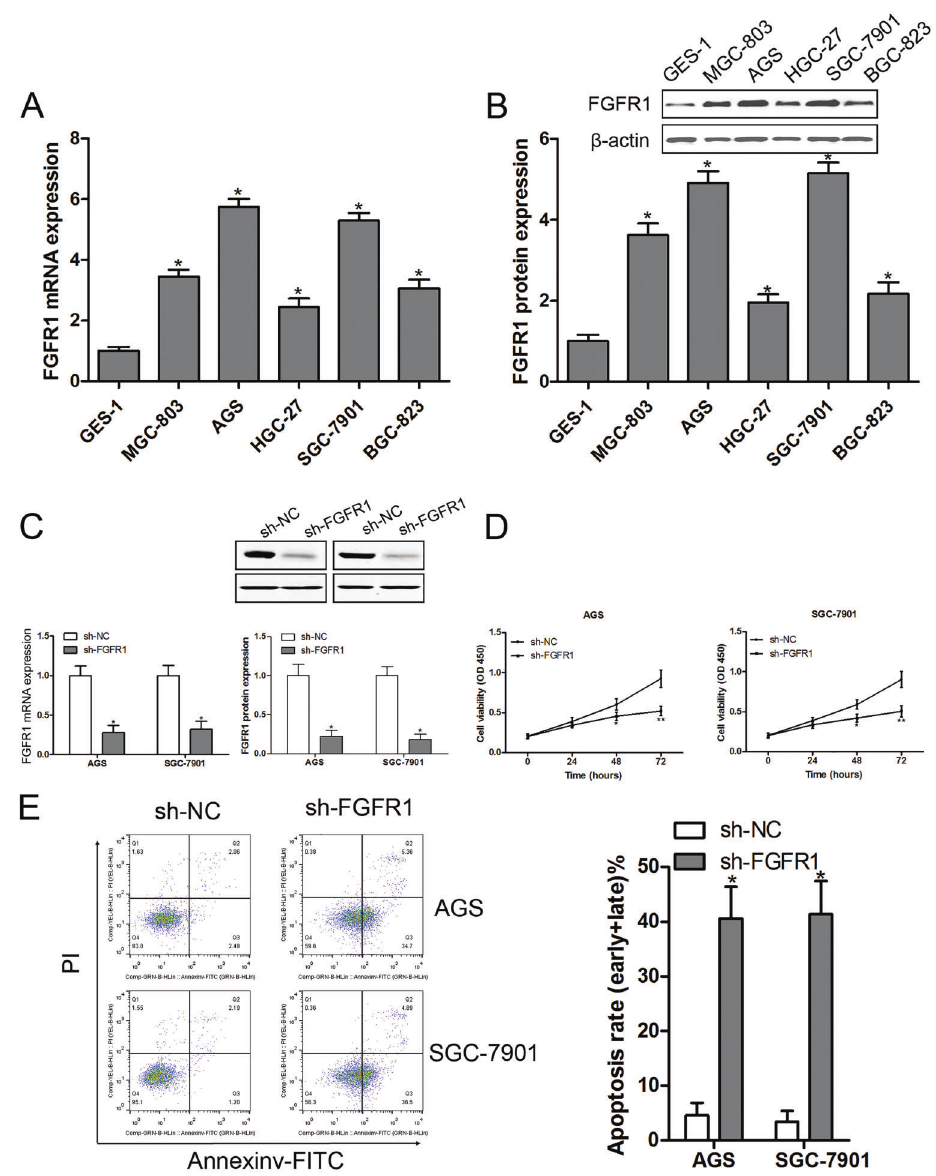
Figure 2. mRNA ( A ) and protein ( B ) expression of fi broblast growth factor receptor 1 (FGFR1) in normal human GES-1 cells and fi ve gastric cancer cell lines measured by RT-qPCR and western blotting, respectively. After transfection with shRNA to inhibit FGFR1 expression, the mRNA and protein expression of FGFR1 were measured by RT-PCR and western blotting, respectively ( C ). Cell viability was measured by CCK-8 assay ( D ), and cell apoptosis by fl ow cytometry in AGS and SGC-7901 cells ( E ). Data are reported as means ± SE for n=3 in each group. *P o 0.05, **P o 0.01 compared to control ( t -test or